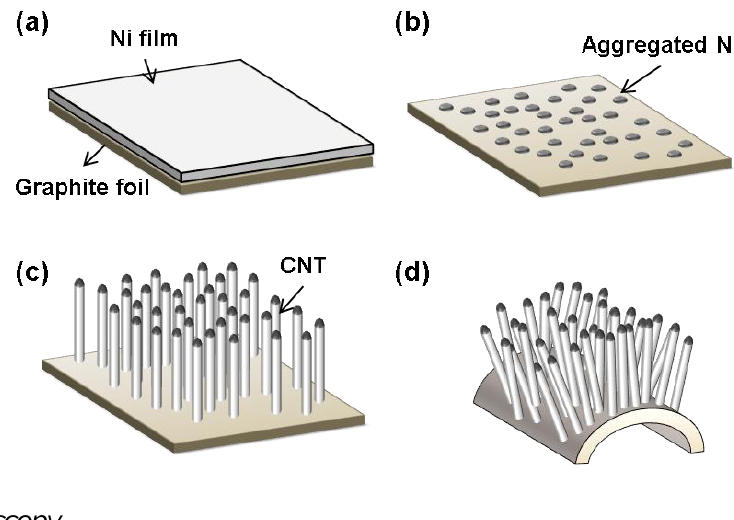
Figure 1. Fabrication and mechanical flexibility test of the all-carbon electrode: ( a ) Ni deposition on graphite foil; ( b ) annealing for seed formation; ( c ) carbon nanotube (CNT) growth and ( d ) flexibility